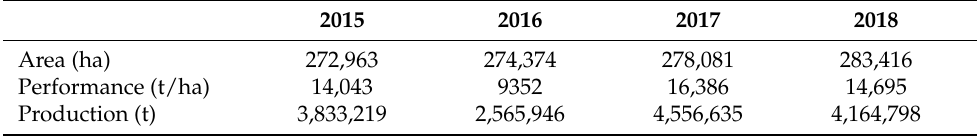
Table 5. Area, performance and estimated production of olive tree cultivation in Extremadura